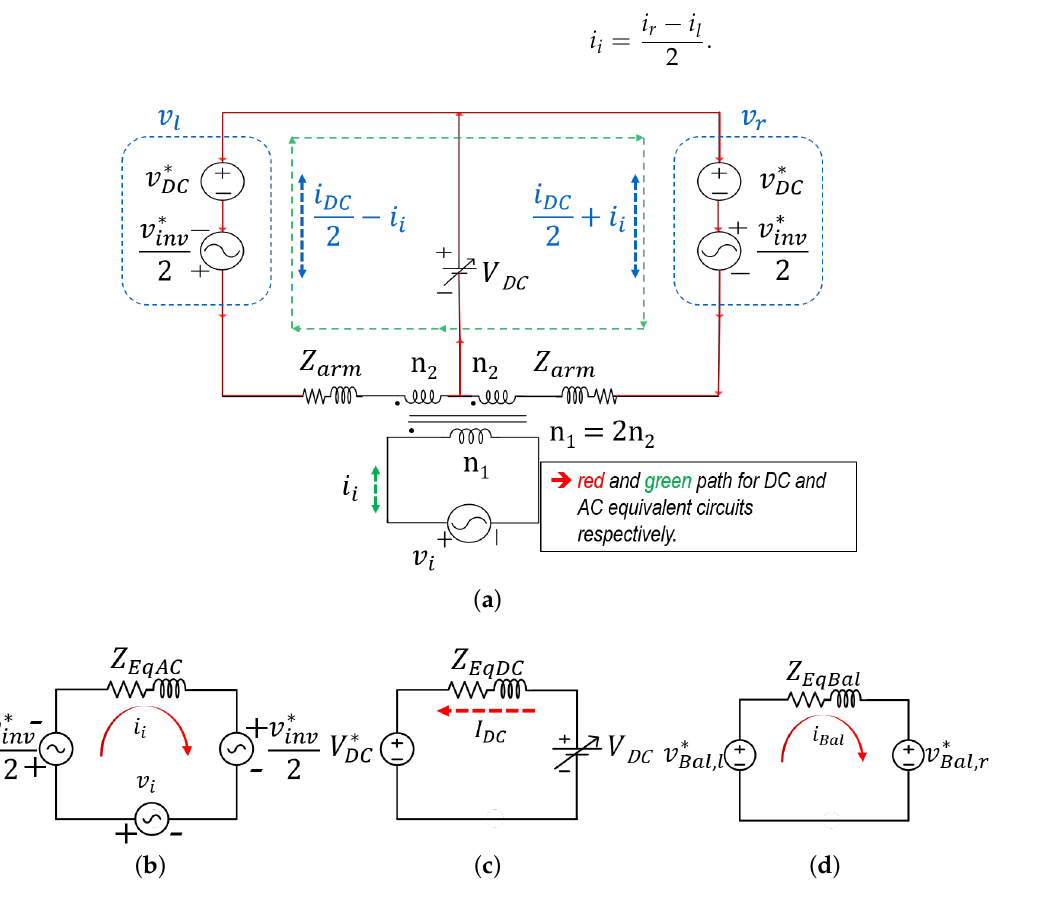
Figure 2. System equivalent circuit ( a ), AC equivalent circuit ( b ), DC equivalent circuit ( c ), and arm balancing equivalent circuit ( d